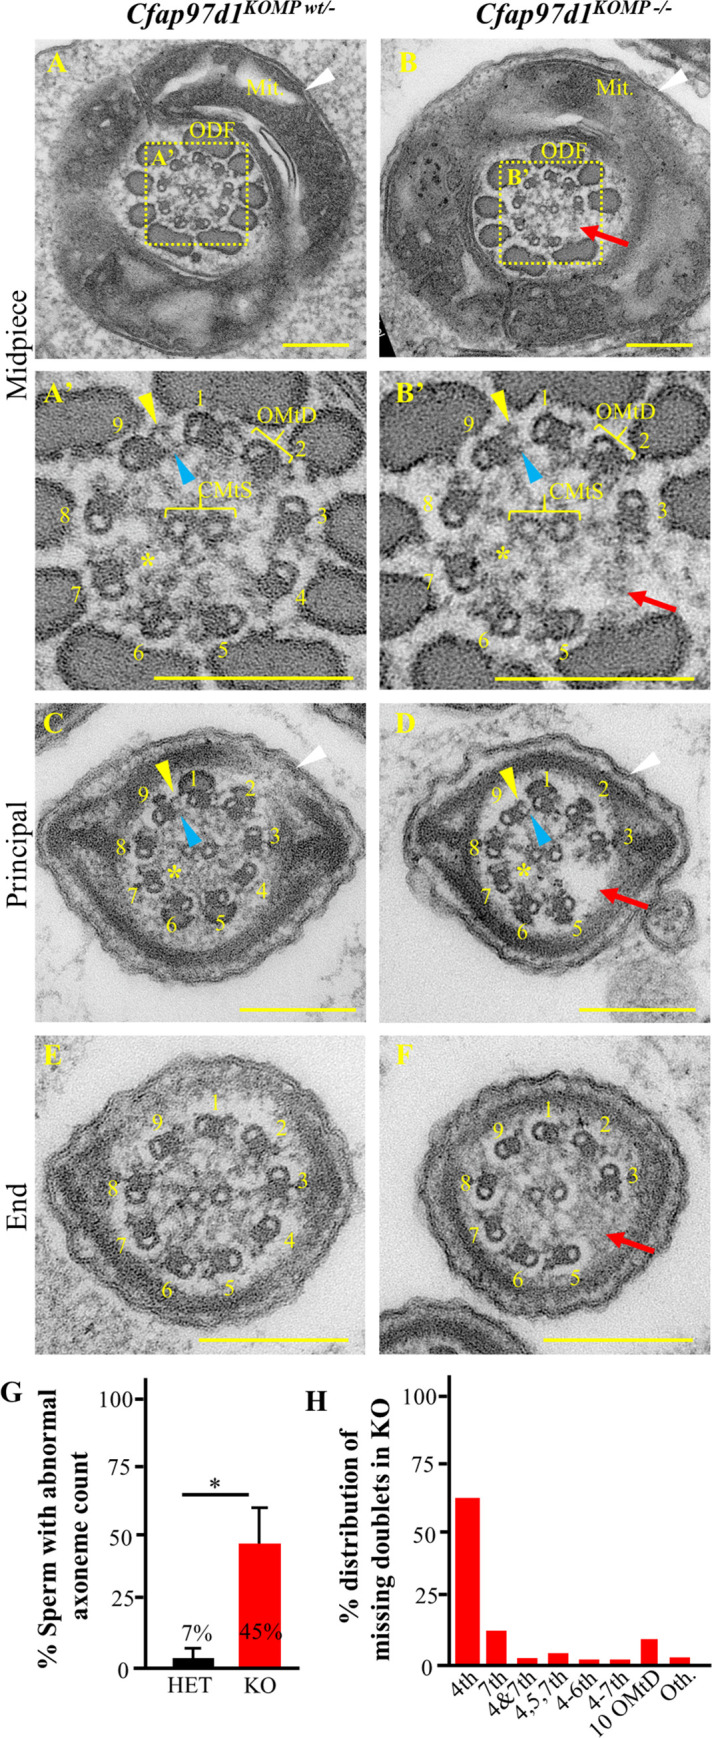
Cfap97d1KOMP-/- sperm have altered doublet counts.(A-F) Representative transmission electron microscope micrographs (TEM). (A, A’, C, E) Normal 9+2 flagellum ultrastructure in control heterozygous sperm and (B, B’, D, F) altered axoneme counts in Cfap97d1KOMP-/- mice. (A) Midpiece cross-section surrounded by mitochondria (Mit) and outer dense fiber (ODF) layers in control. (B) Micrograph depicts regular distribution of mitochondria (Mit), the rarely noted single missing one ODF and frequently missing 4th outer microtubule doublet (red arrow) in Cfap97d1KOMP-/- sperm. (A’, B’) Enlarged midpiece images from A and B depict outer dynein arms (yellow arrowheads), inner dynein arms (blue arrowhead), radial spokes (yellow star) and central microtubule singlets (CMtS) in control and Cfap97d1KOMP-/- mouse sperm. The fourth outer microtubule doublet (OMtD) and radial spoke (yellow star) adjacent to it was frequently missing (red arrow) in Cfap97d1KOMP-/-
(B’). (C, D) The principal piece has all intact axonemal components in control (C), whereas Cfap97d1KOMP-/- is missing the fourth OMtD and radial spoke adjacent to it (red arrow). (E, F) The end piece has the 9+2 structure in control (E) whereas Cfap97d1KOMP-/- is missing the fourth OMtD (red arrow). (G) There were abnormal axoneme counts in 45% of Cfap97d1KOMP-/- sperm and in 7% of heterozygous control sperm. (H) 63% of Cfap97d1KOMP-/- axonemes were missing the 4th OMtD. Note: There were 186 control and 160 Cfap97d1KOMP-/- sperm cross-sections analyzed from three mice of each genotype. *P < 0.05, Student’s t-test, (±SD).